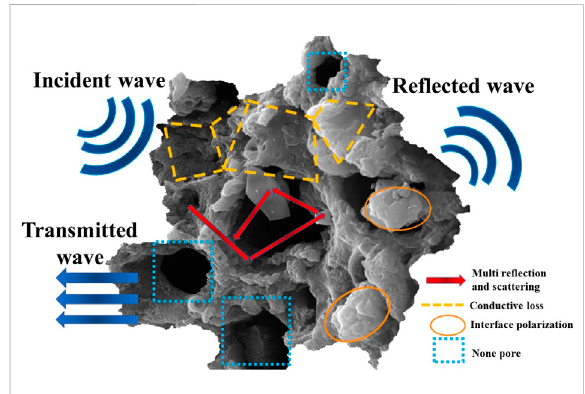
FIGURE 11 Schematic illustration of microwave absorption mechanisms of Fe 3 O 4 /AC